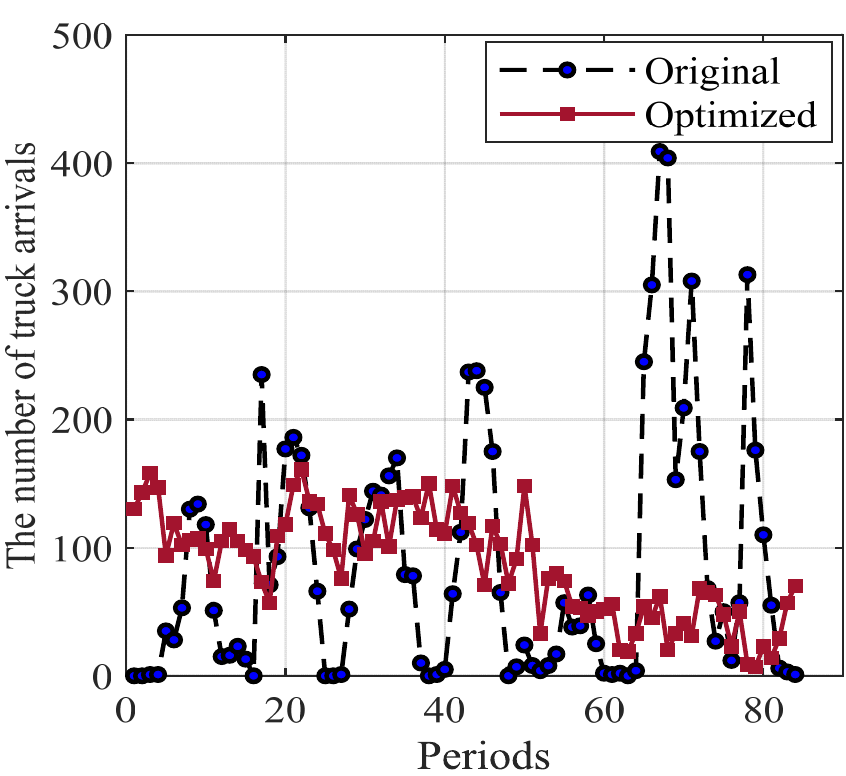
Figure 11. The comparison between original truck arrivals and optimized truck arrivals.